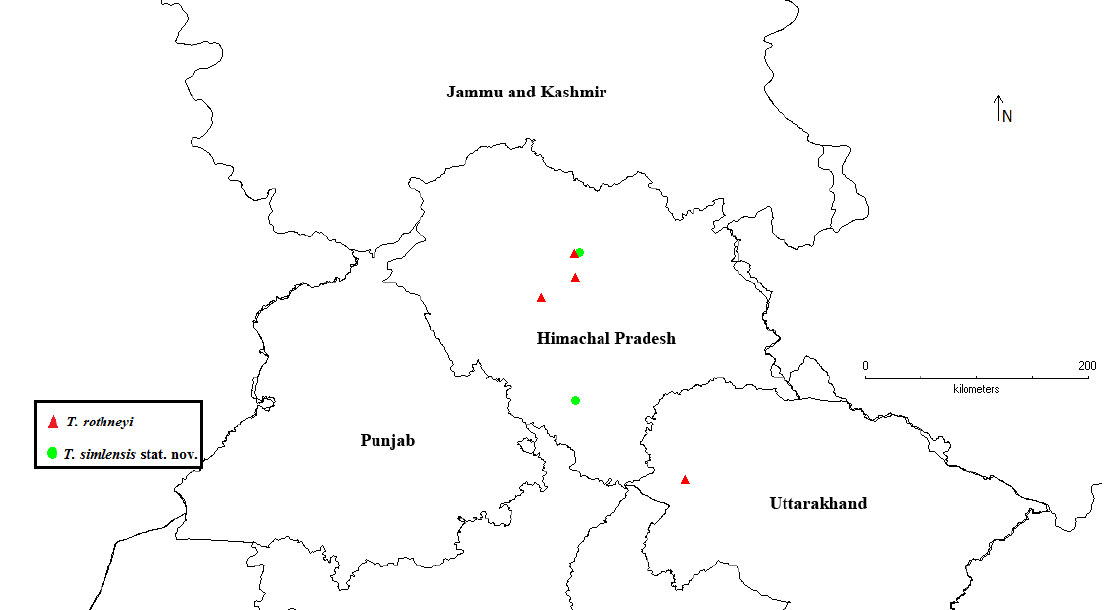
Fig 18 . Map showing the distribution of Temnothorax simlensis and Temnothorax